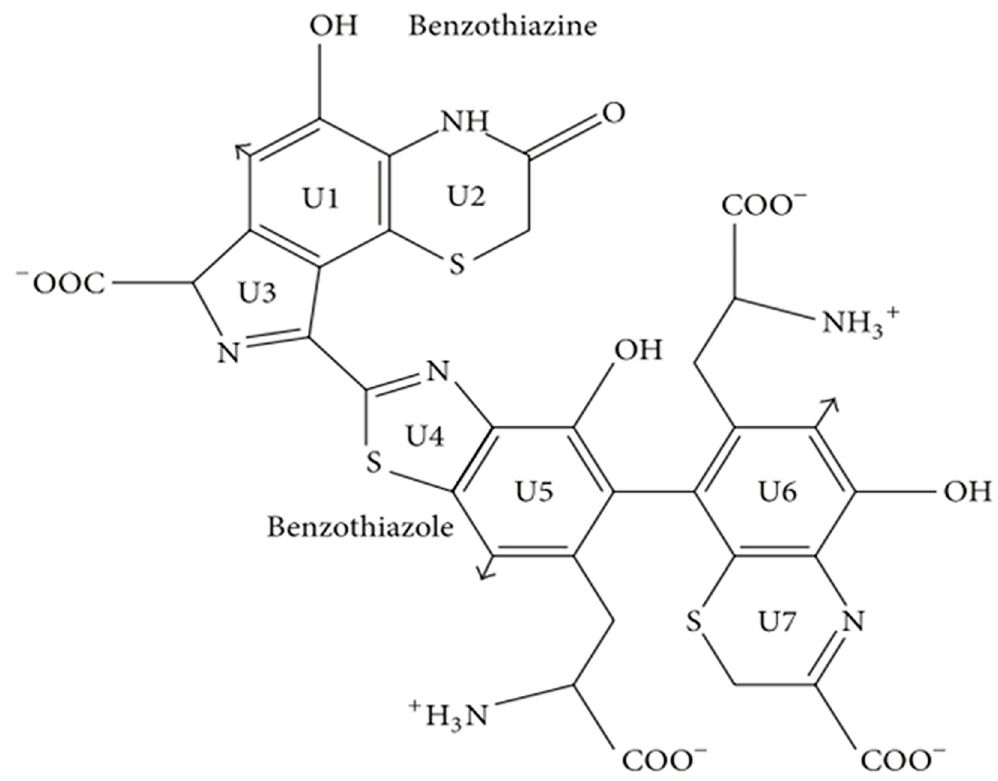
Figure 3. Structural diagram of benzothiazine and benzothiazole. Adapted from [3] with minor